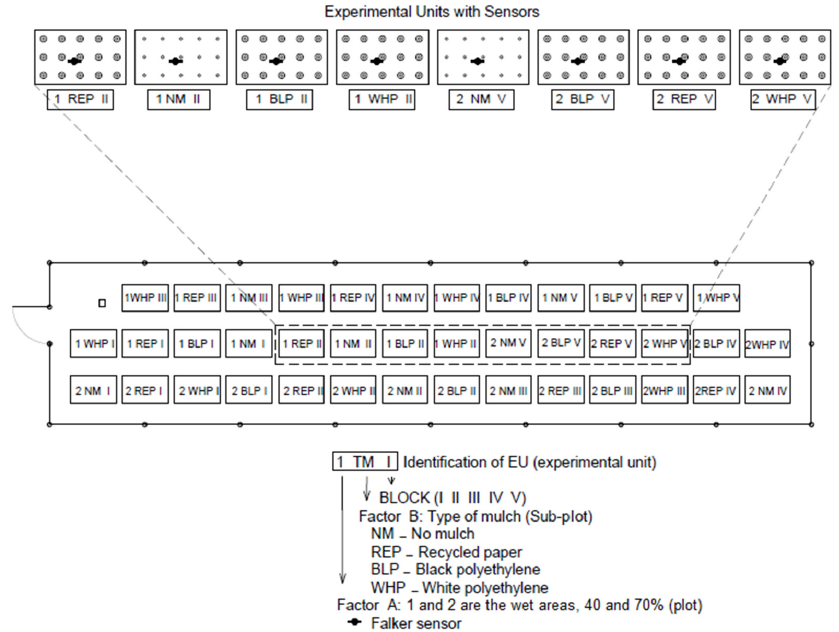
Figure 3. Diagram of the protected environment with the arrangement of wet areas, mulches, replicates (block), and positioning of the sensors in the experimental units.